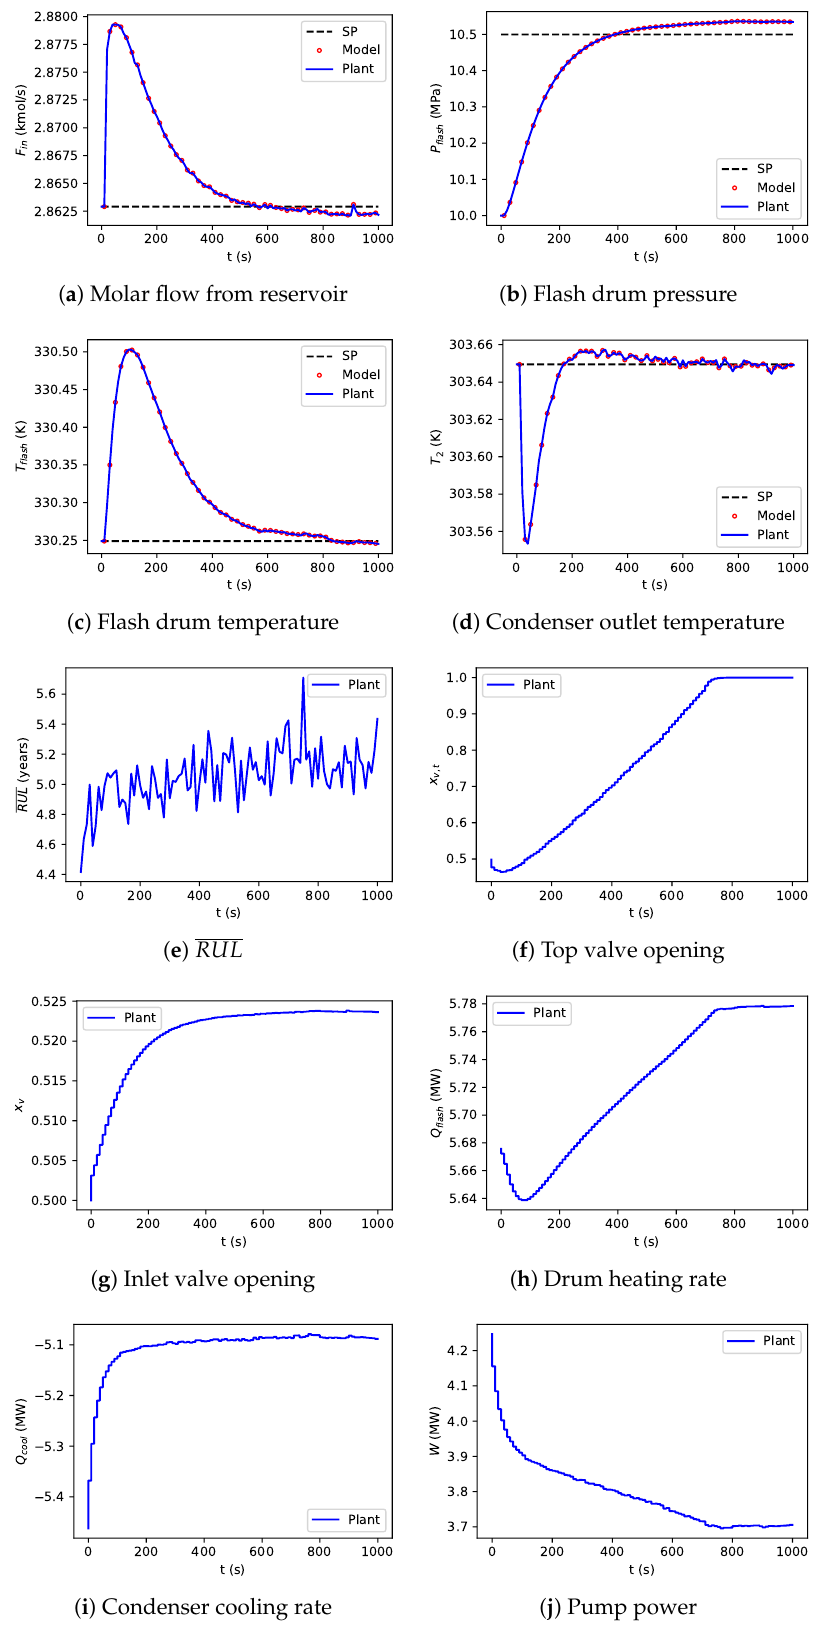
Figure 9. Health-aware control (HAC) simulation— w HAC = 5, N part =